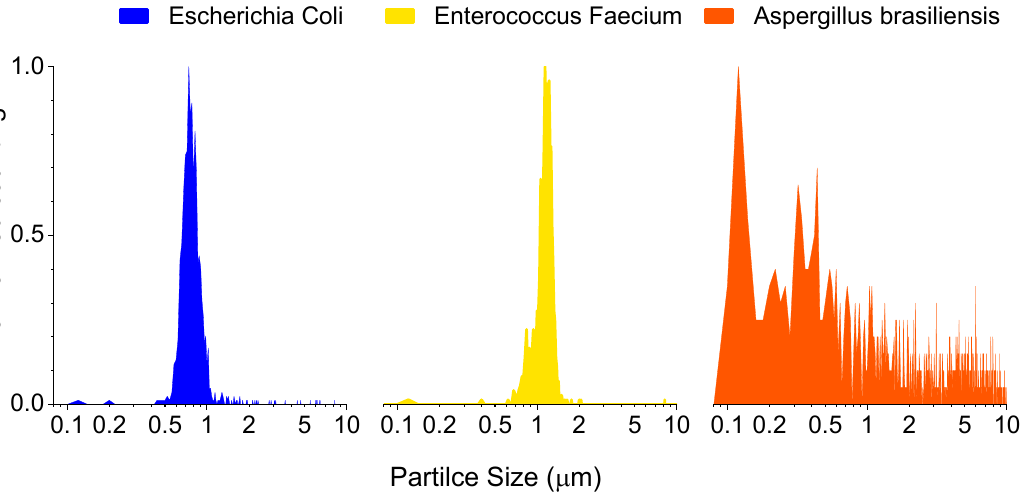
Figure 6. Particle size distribution of Escherichia coli , Enterococcus faecium, and Aspergillus brasiliensis .